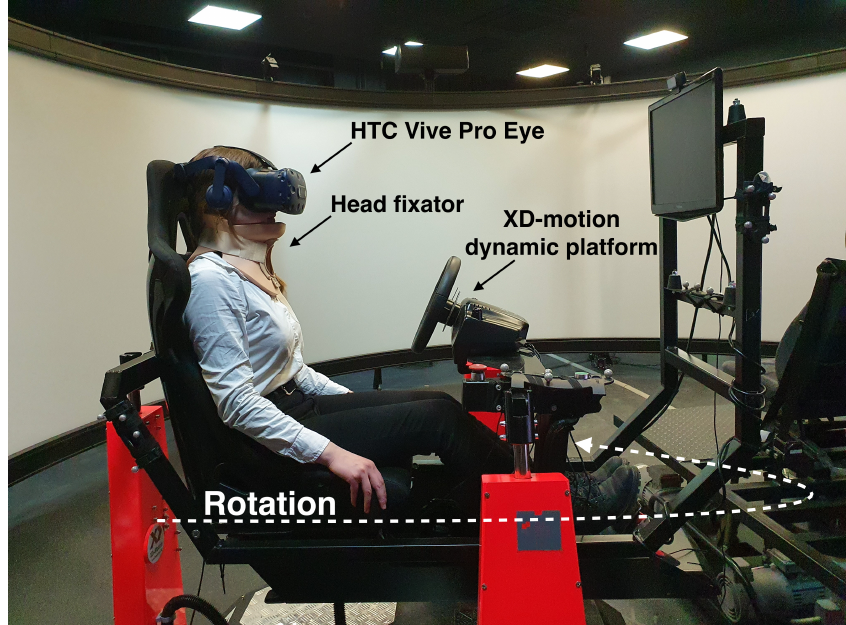
Figure 2. Experimental setup for collecting the ocular response to the controlled accelerated movements. During the processing phase, each movement pattern is handled individually. The leading and trailing 3 s of each recording are trimmed. The view direction vector is converted from a headset coordinate system into angles of eye rotation in horizontal and vertical planes. The head coordinates data were sampled at a lower frequency than eye- tracking data, so the former were smoothed using a Gaussian filter. Head orientation quaternion was converted into Euler angles. After leaving only data corresponding to horizontal angles, angular velocity and linear acceleration were